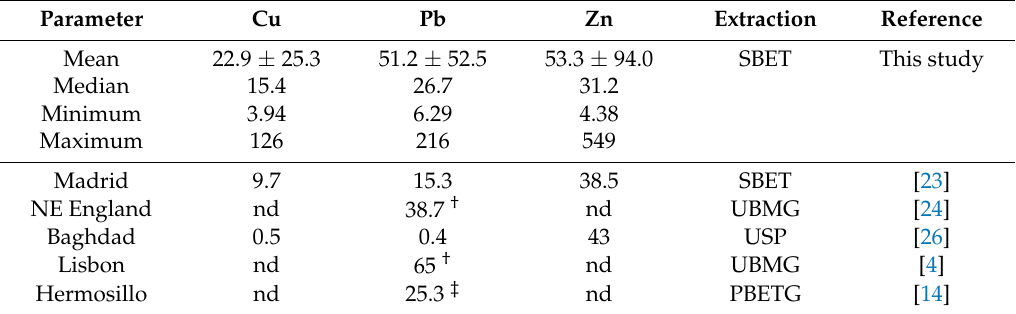
Table 3. Bioaccessible copper, lead and zinc in soils from Scottish schools (mg · kg − 1 , n = 37) together with results from literature.